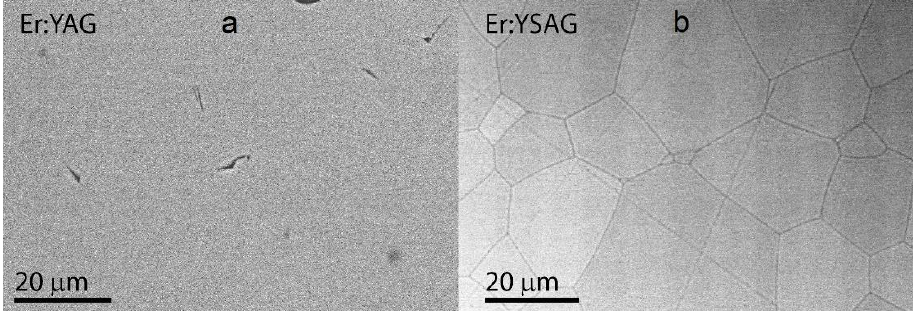
Figure 3. SEM micrographs of the ( a ) Er:YAG and ( b ) Er:YSAG ceramic surfaces.